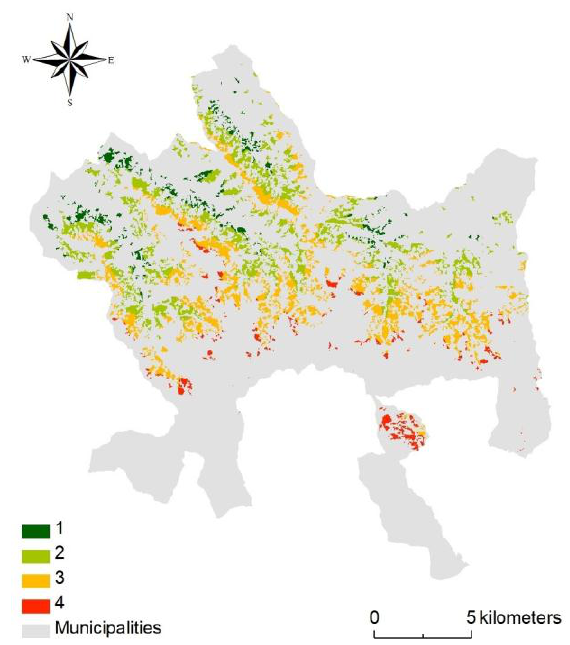
Figure 5. Region group elaboration using GIS program to identify the degree of feasibility of cultivation and collection of hazelnuts depending on the morphological and spatial characteristics. Source: own elaboration.